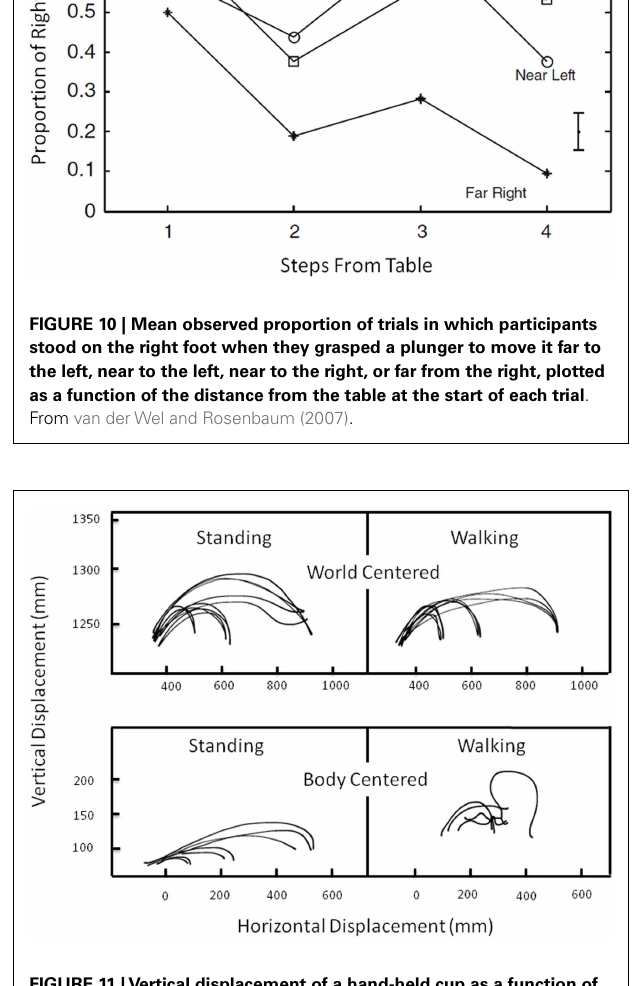
FIGURE 11 |Vertical displacement of a hand-held cup as a function of horizontal displacement of the same cup when standing (left column) or walking (right column) and when the data are plotted in extrinsic spatial coordinates (top row) or intrinsic joint coordinates (bottom row) . Adapted from Marteniuk and Bertram